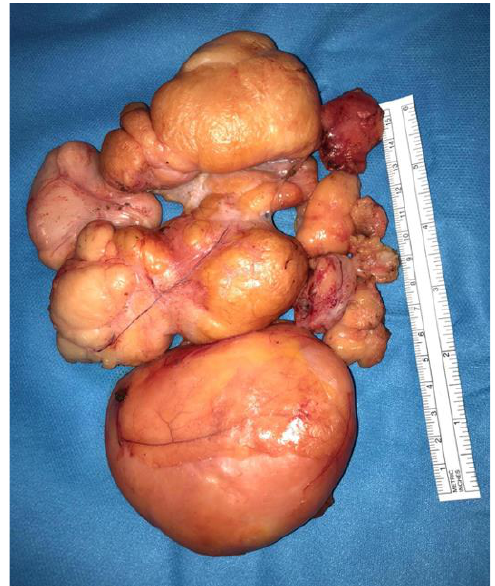
Figure 1. Macroscopic findings on the surgical specimen. A solid mass of yellowish adipose tissue was removed in fragments, the major with a maximum diameter of 14.5 cm. Macroscopically, the tumor appeared as a solid mass of adipose tissue with heteroge- neous consistency and a yellowish lipoma-like cut surface. Histopathologic examination revealed a lesion composed of mature fat with variably sized adipocytes separated into lobules by bland fibrous septa. Cellularity was low and mitotic figures were uncommon. Atypical spindle cells in fibrous/fibromyxoid stroma, or adjacent to vessels were seen. Rare lipoblasts were found. No heterologous differentiation was identified. Immunohistochemi- cally, neoplastic cells showed positivity for MDM2 and CDK4 (Figure